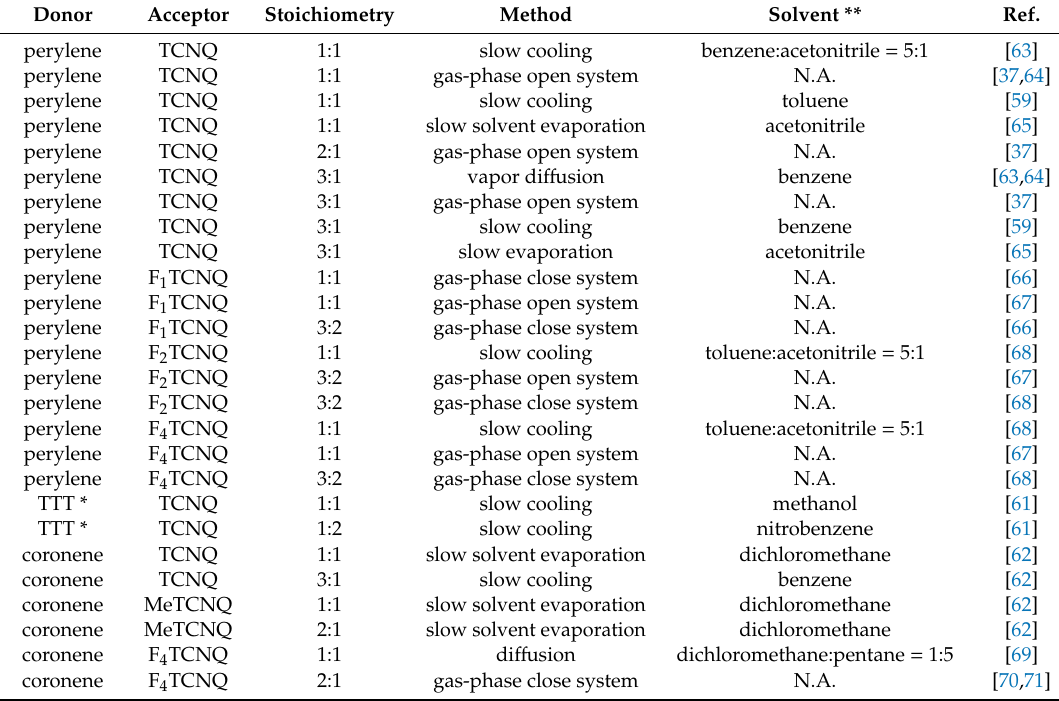
Table 1. Single crystal growth parameters of di ff erent CTCs